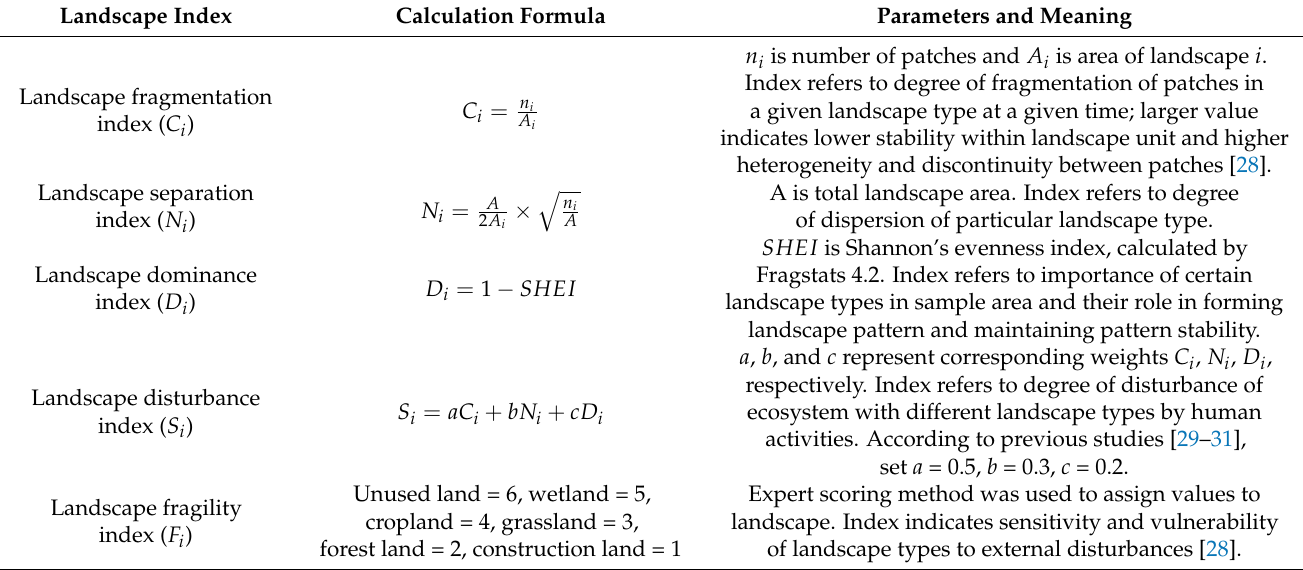
Table 1. Calculation formulas and parameters of landscape